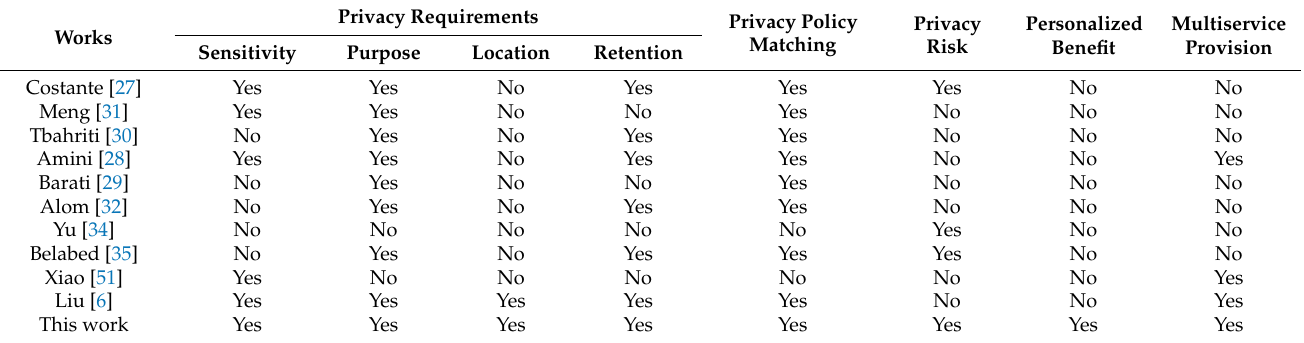
Table 7. The comparison of privacy-preserving service selection